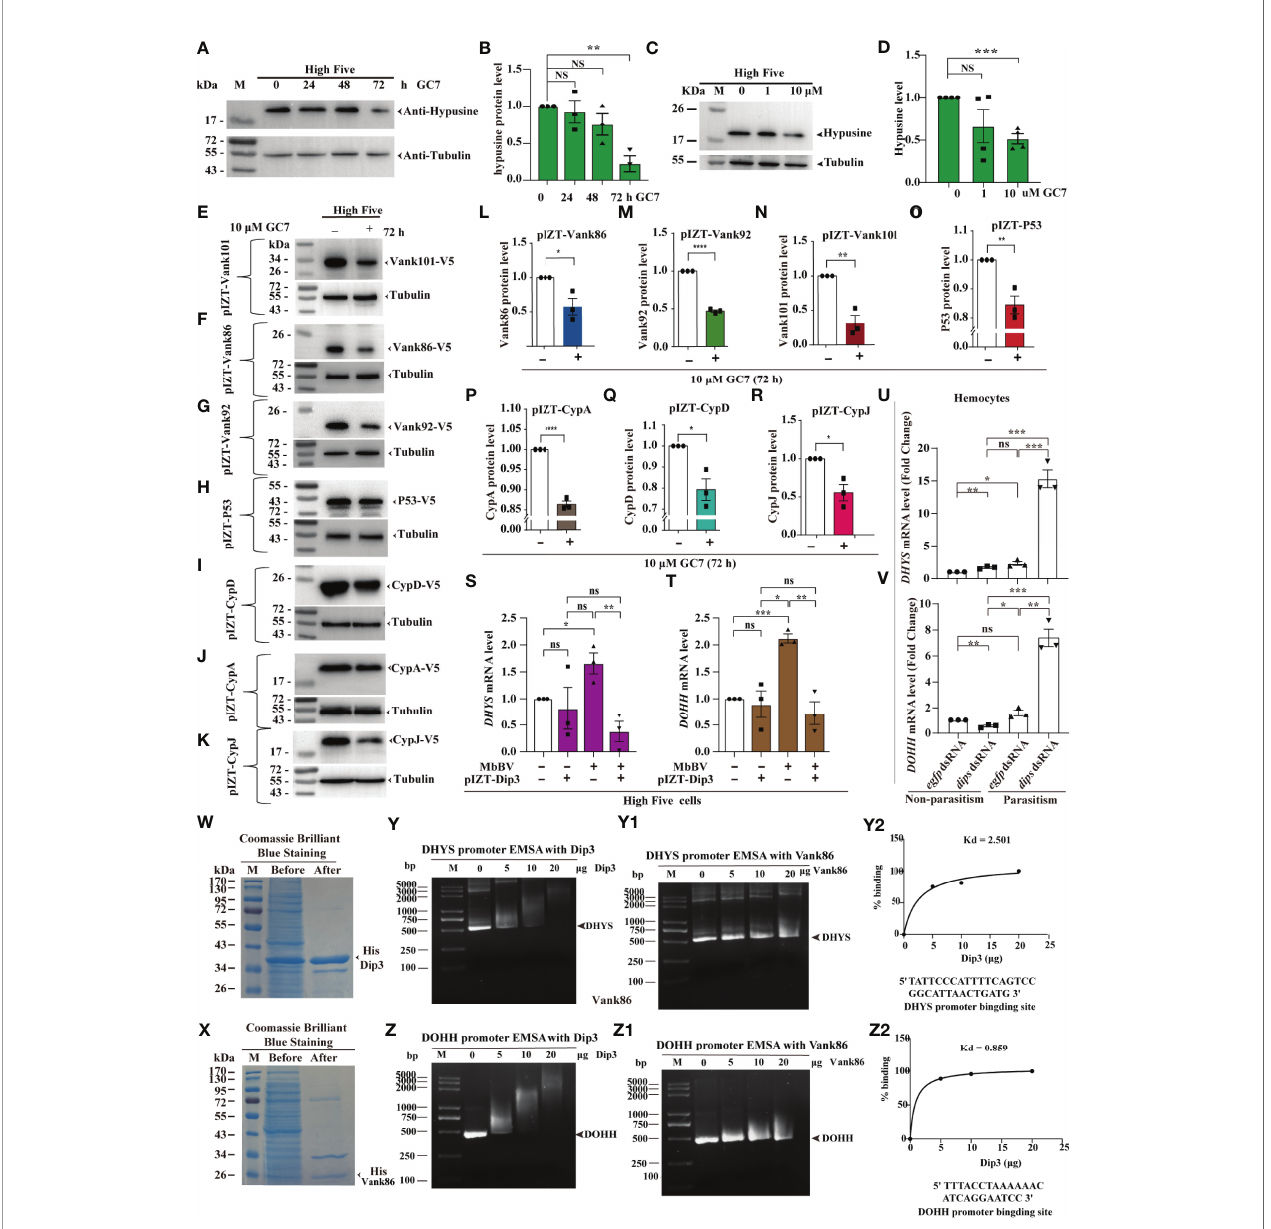
FIGURE 4 | Viral-hypusination-dependent proteins positively regulated DHYS and DOHH. (A-R) GC7 inhibited hypusination-dependent protein expression. GC7 inhibition of hypusination at different times (A, B) and different dosages (C, D) ; GC7 inhibited the ectopic expression of the integrated proteins, Vank86, 92, 101, P53, CypA, CypD, and CypJ (E-K) ; Column summarizes the level of Vank 86, 92, 101, P53, CypA, CypD, and CypJ in High Five cells, normalized to the total protein level (L-R) . * p < 0.05; ** p < 0.01, *** p < 0.001, **** p < 0.0001, ns, no signi fi cant difference, error bars represent SEM. Unpaired Student ’ s t -test with Holm-Sidak method for multiple t test; n = 3. (S-V) Viral-hypusination-dependent proteins positively regulated DHYS and DOHH transcription. Ectopicexpression of Dip3 decreased the expression of DHYS and DOHH infected with MbBV (S, T) ; in vivo , parasitism plus dip3 dsRNA increased the expression of DHYS and DOHH (U, V) . * p < 0.05, ** p < 0.01, *** p < 0.001, **** p < 0.0001, ns, no signi fi cant difference, error bars represent SEM. Unpaired Student ’ s t -test with Holm-Sidak method for multiple t test; n = 3. ( W-Z2 ) Electrophoretic mobility shift assay (EMSA) to detect the promoter of DHYS and DOHH interaction with Dip3. Puri fi ed Dip3 and Vank86 proteins (W, X) ; DHYS (Y) or DOHH (Z) promoter EMSA with Dip3, Vank86 as a control protein ( Y, Z1 ); DHYS ( Y2 ) and DOHH ( Z2 ) presented high af fi nity. See also Figure S4